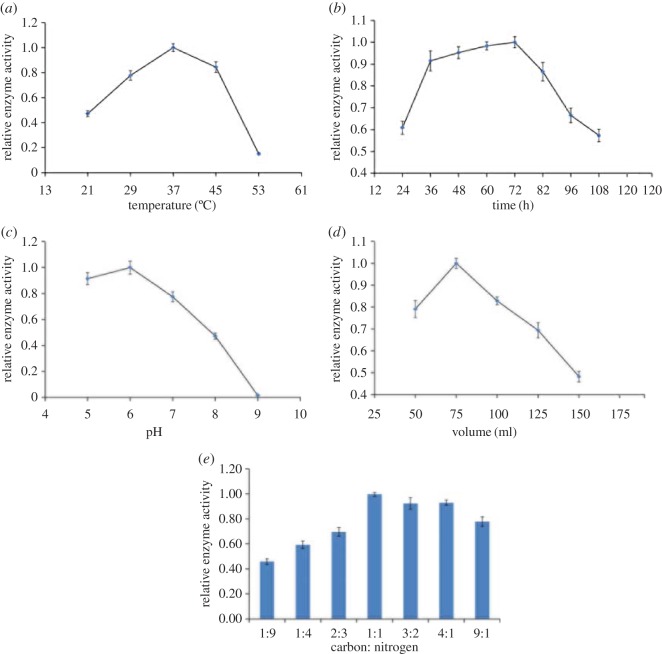
Optimization of fermentation conditions of cellulase secreted by B. amyloliquefaciens S1. (a) Effect of fermentation temperature on enzyme production; (b) effect of fermentation time on enzyme production; (c) effect of initial pH of medium on enzyme production; (d) effect of carbon and nitrogen ratio of medium on enzyme production and (e) effect of medium volume aeration on enzyme production.